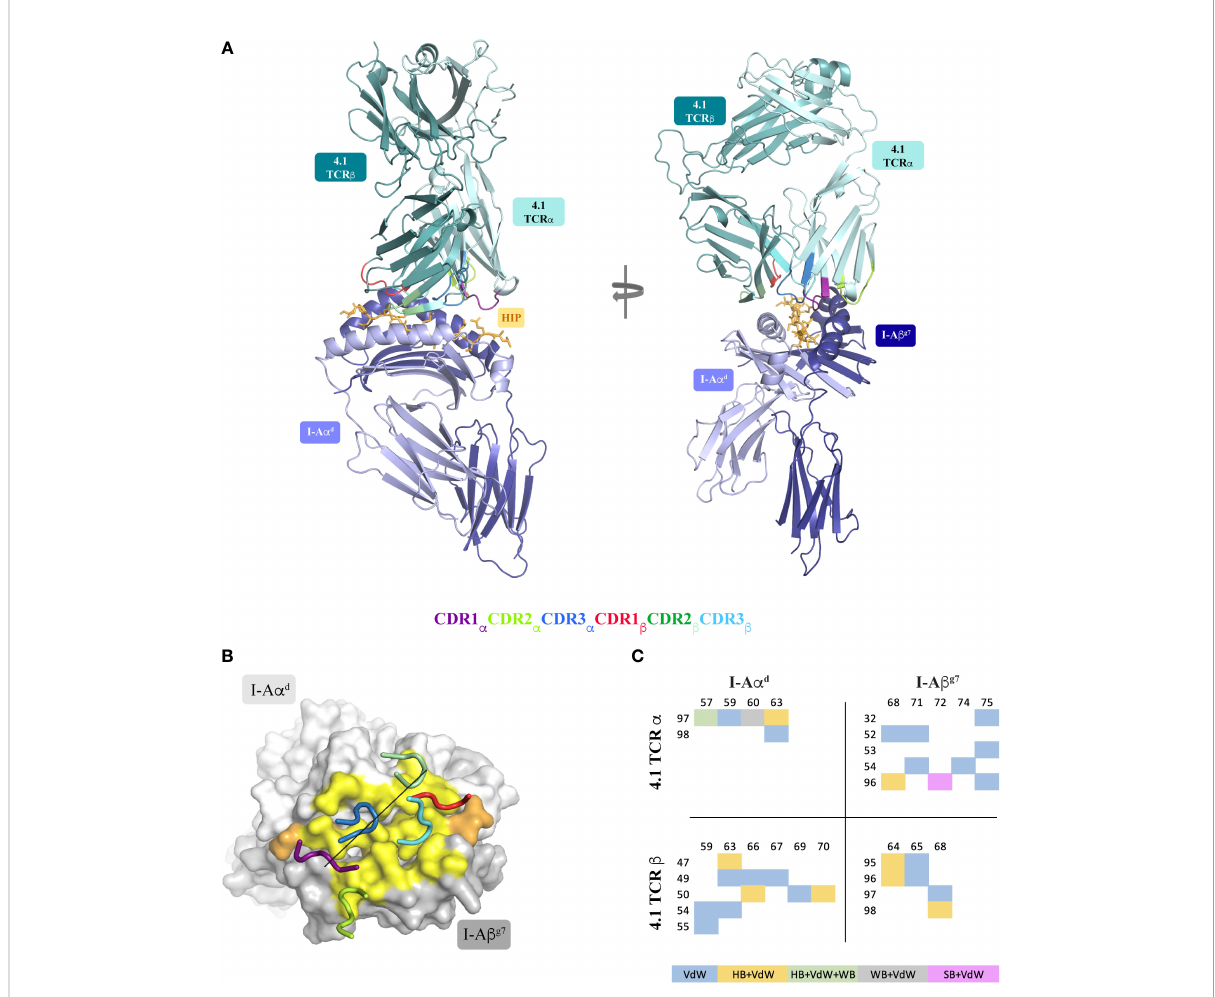
FIGURE 3 Structure of the 4.1-TCR : HIP39/I-A g7 complex. (A) Side and front views of the 4.1-TCR bound to HIP39/I-A g7 . The a / b chains of the TCR are colored pale cyan and light teal, respectively, and the CDR loops highlighted as described in the legend underneath. I-A a d and I-A b g7 are in light blue and deep blue colors and the HIP antigen shown in stick format in orange color. (B) Surface representation of I-A a d and I-A b g7 in light and dark grey colors, respectively, and of the bound HIP antigen, in orange color. The 4.1-TCR footprint on I-A g7 is colored yellow and highlights residues on the MHC and antigen that establish any type of contact ( ≤ 4 Å) with the TCR. The CDR loops are displayed in tube format with the color register described in (A) . The black straight line connects the conserved disul fi de bridges of the TCR a and TCR b variable regions. (C) Distribution and chemical nature of the intermolecular contacts in the 4.1-TCR : HIP39/I-A g7 complex. VdW, Van der Waals; HB, Hydrogen bond; WB, Water bridge; SB, Salt